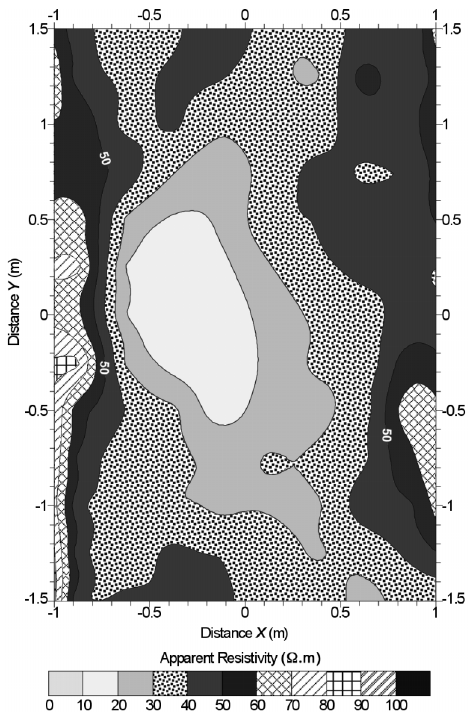
Fig. 3. Apparent resistivity map from the gradient